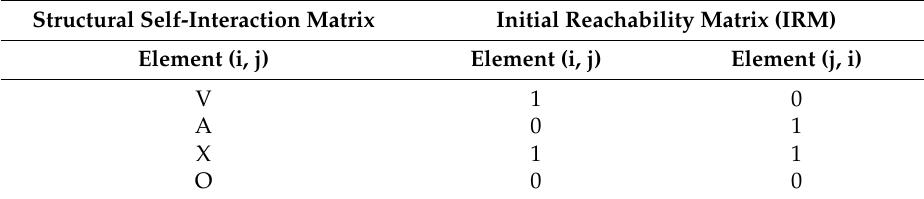
Table 3. Rules of IRM.